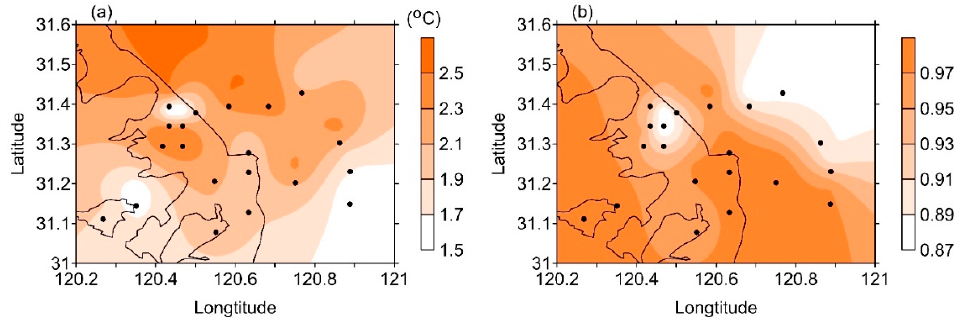
Figure 3. Spatial distributions of the ( a ) root mean square error and ( b ) Correlation Coefficient of the near surface air temperature. The black dots indicate the locations of the meteorological stations used in this paper.